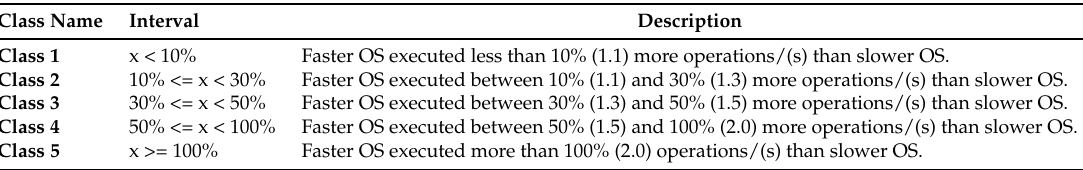
Table 8. Digital signal processing (DSP) benchmark performance results